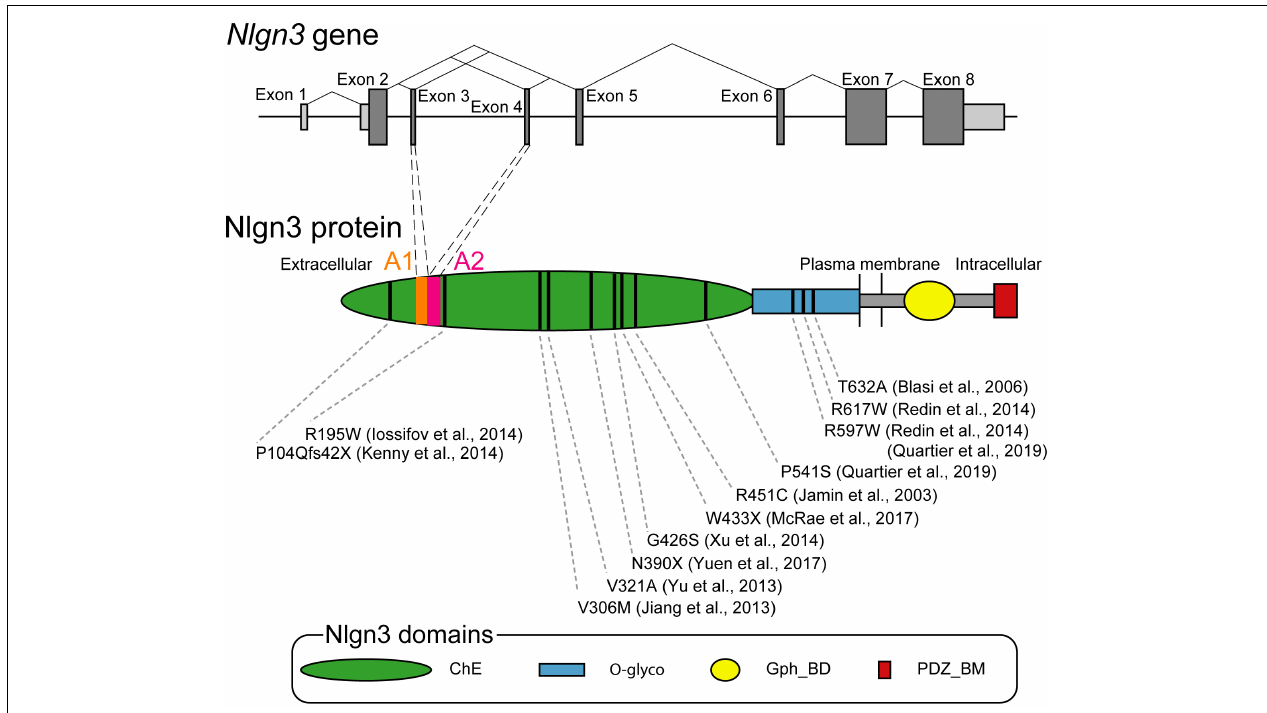
FIGURE 1 | Genomic and protein structures of Neuroligin 3 (Nlgn3). Upper schema showing the organization of human Nlgn3 and splicing patterns at exons 3 and 4. Bars indicate exons with the coding and untranslational regions colored in dark and bright gray, respectively. Lower schema showing the domain structure of Nlgn3. Bars indicate positions of the mutations associated with ASD and schizophrenia. ChE, cholinesterase-like domain, Gph_BD, gephyrin binding domain; O-glyco, O-linked glycosylation sites; PDZ_BM, PDZ domain-binding